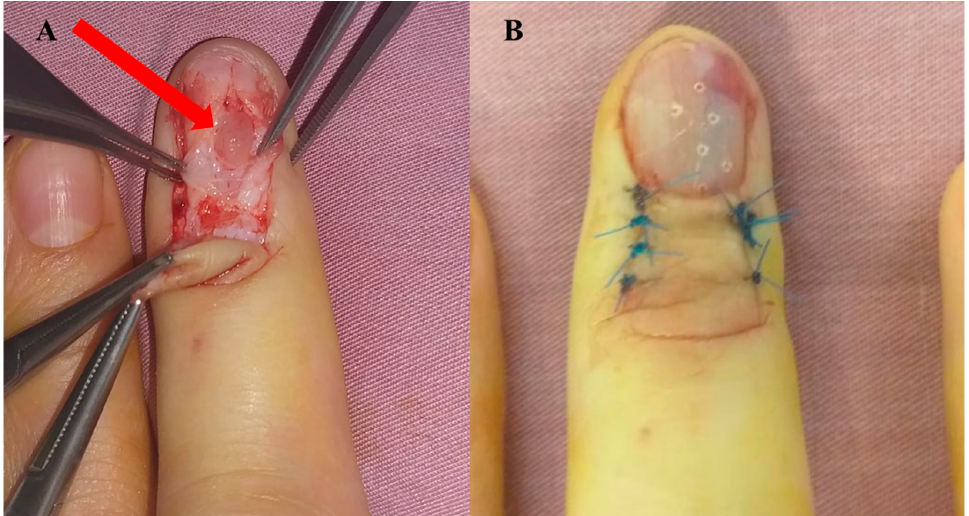
Figure 4. Glomus tumor of the middle finger nail bed. ( A ) Intraoperative appearance, ( B ) postoperatively result.